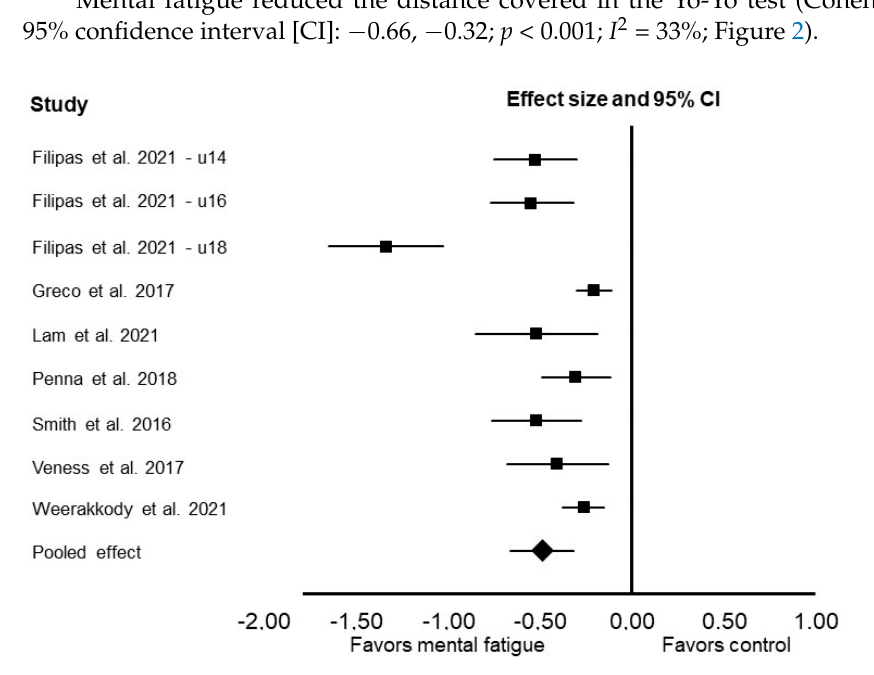
Figure 2. Forest plot presenting the results of the random-effects meta-analysis comparing the effects of control vs. mental fatigue on Yo-Yo test performance. Data are reported as Cohen’s d (effect size) and 95% confidence interval (CI). The diamond at the bottom presents the overall effect. The plotted squares denote effect sizes, and the whiskers denote their 95% CIs.